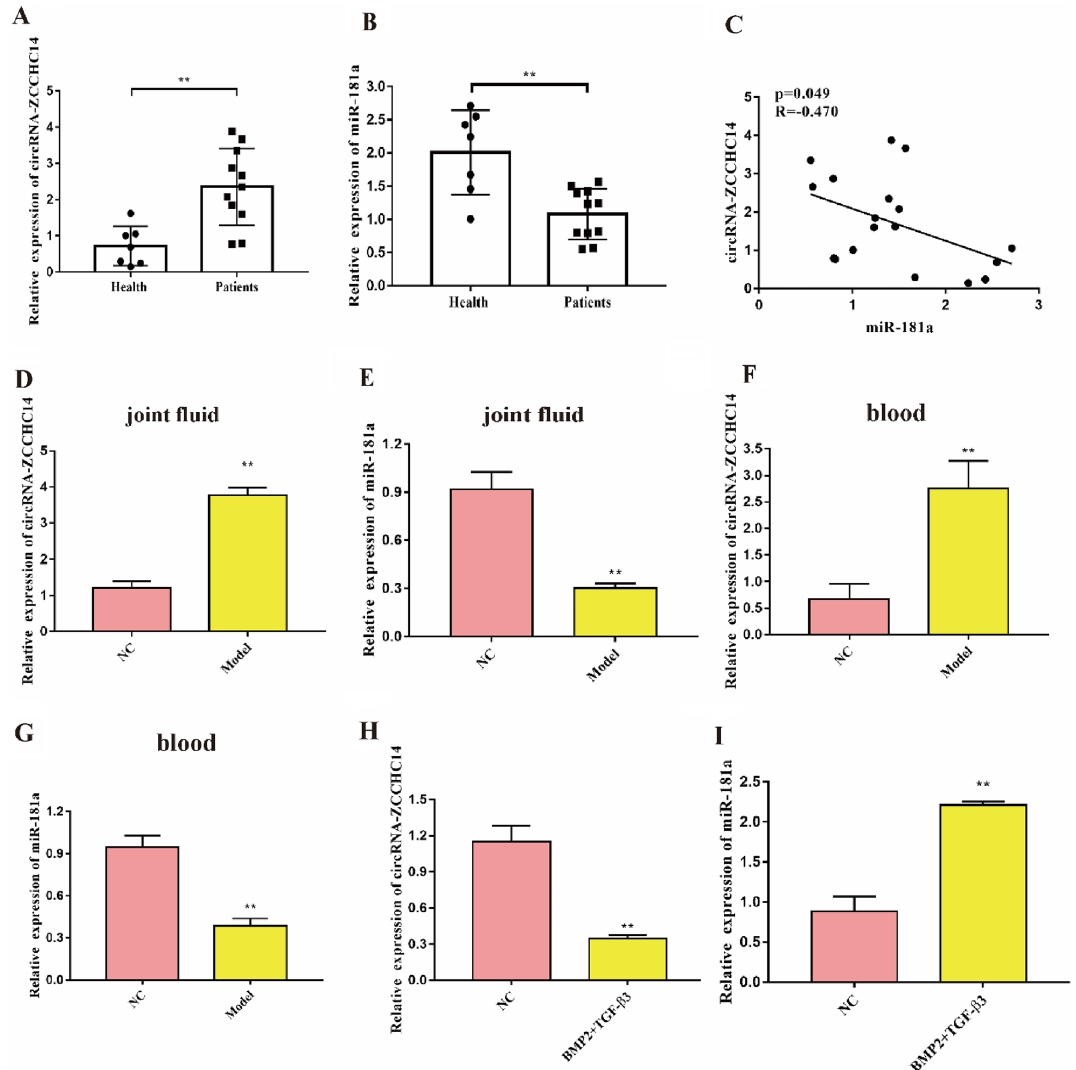
Figure 1. Expression of circRNA-ZCCHC14 and miR-181a ( A ) Detection of the circRNA-ZCCHC14 expression in clinical samples by RT ‒ qPCR; ( B ) Detection of miR-181a expression in clinical samples by RT ‒ qPCR; ( C ) The correlation between circRNA-ZCCHC14 and miR-181a was analysed; ( D ) RT ‒ qPCR was used to detect the expression of circRNA-ZCCHC14 in animal joint fluid; ( E ) RT ‒ qPCR was used to detect the expression of miR-181a in animal joint fluid; ( F ) The expression of circRNA-ZCCHC14 in animal blood was detected by RT ‒ qPCR; ( G ) RT ‒ qPCR was used to detect the expression of miR-181a in animal blood; ( H ) Detection of the expression of circRNA-ZCCHC14 in the cell model by RT ‒ qPCR; ( I ) Detection of the expression of miR-181a in the cell model by RT ‒